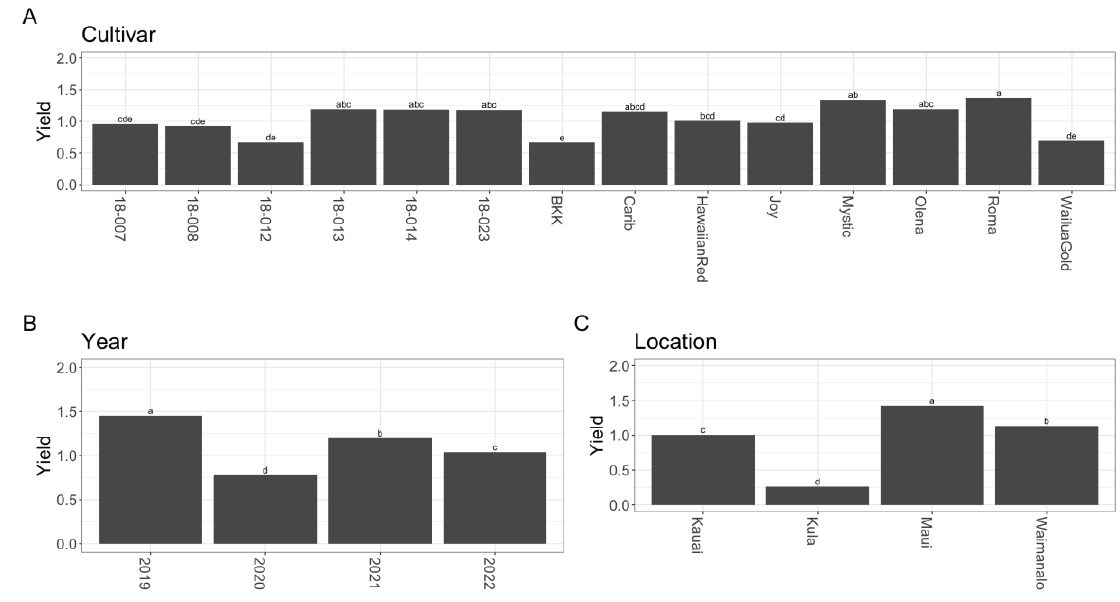
Figure 4. Yield (kg∙plant − 1 ) comparisons based on a multivariate model accounting for the effects of ( A ) Cultivar, ( B ) year, and ( C ) location.